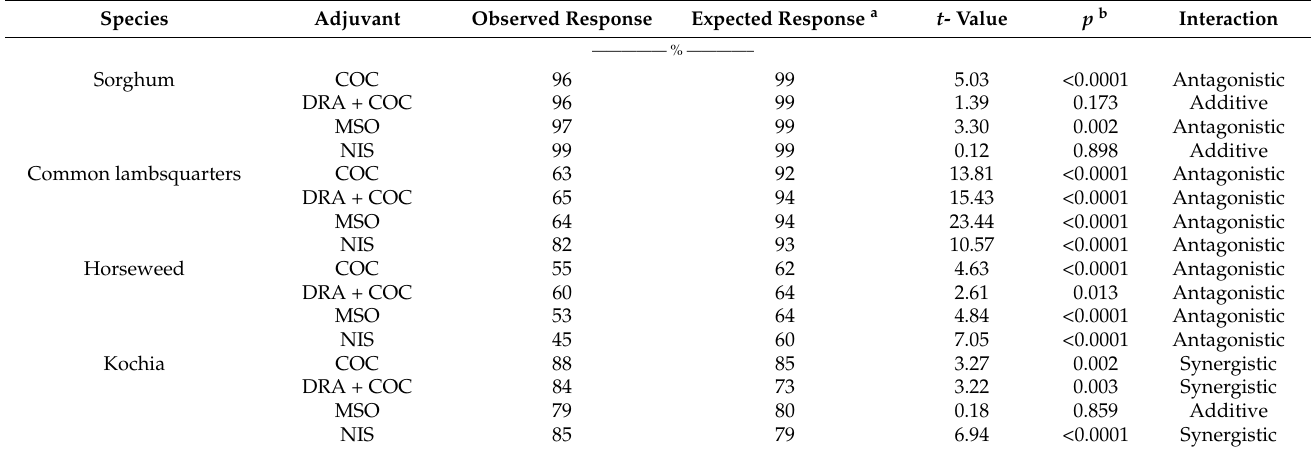
Table 4. Interaction of glyphosate plus lactofen influenced by the addition of different adjuvants based on dry biomass in glyphosate-susceptible populations of sorghum and common lambsquarters and glyphosate-resistant populations of horseweed and kochia from a greenhouse study conducted in